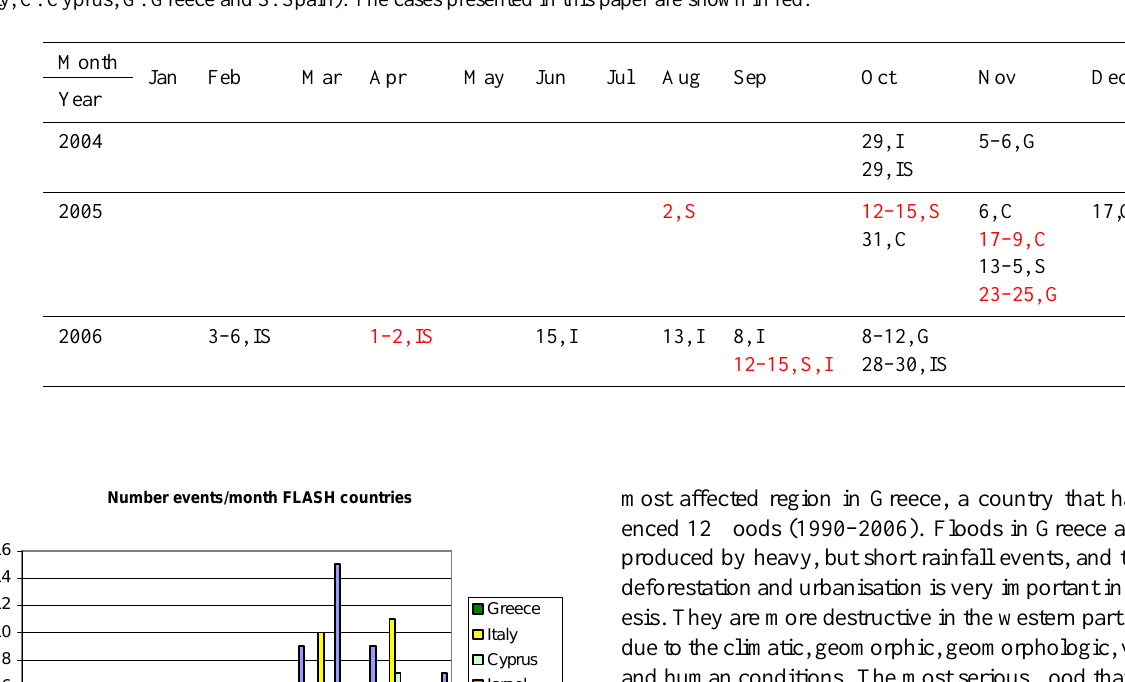
Table 3. Selected flood events considered by the FLASH project. The day of the month of each event of each month is shown (IS: Israel, I: Italy, C: Cyprus, G: Greece and S: Spain). The cases presented in this paper are shown in red.